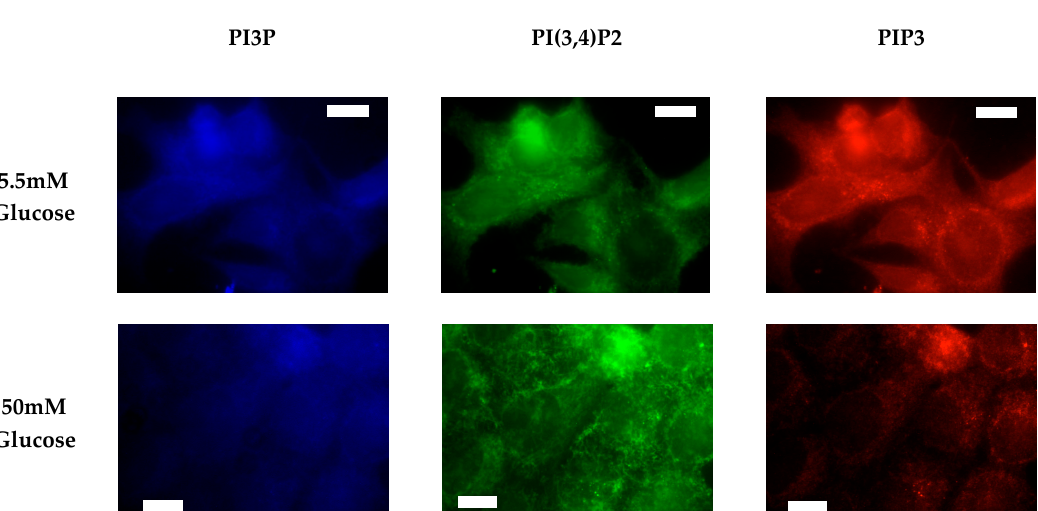
Figure 3. Glucose concentration changes cellular expression of PIPs in hormone receptor positive cells. Representative fixed cell fluorescent images of MCF7 cells cultured in normal (5.5 mM) and hyperglycemic (50 mM) serum glucose with immunofluorescent tags against PI3P, PI(3,4)P2, and PIP3. Scale bars represent 10 μ m.